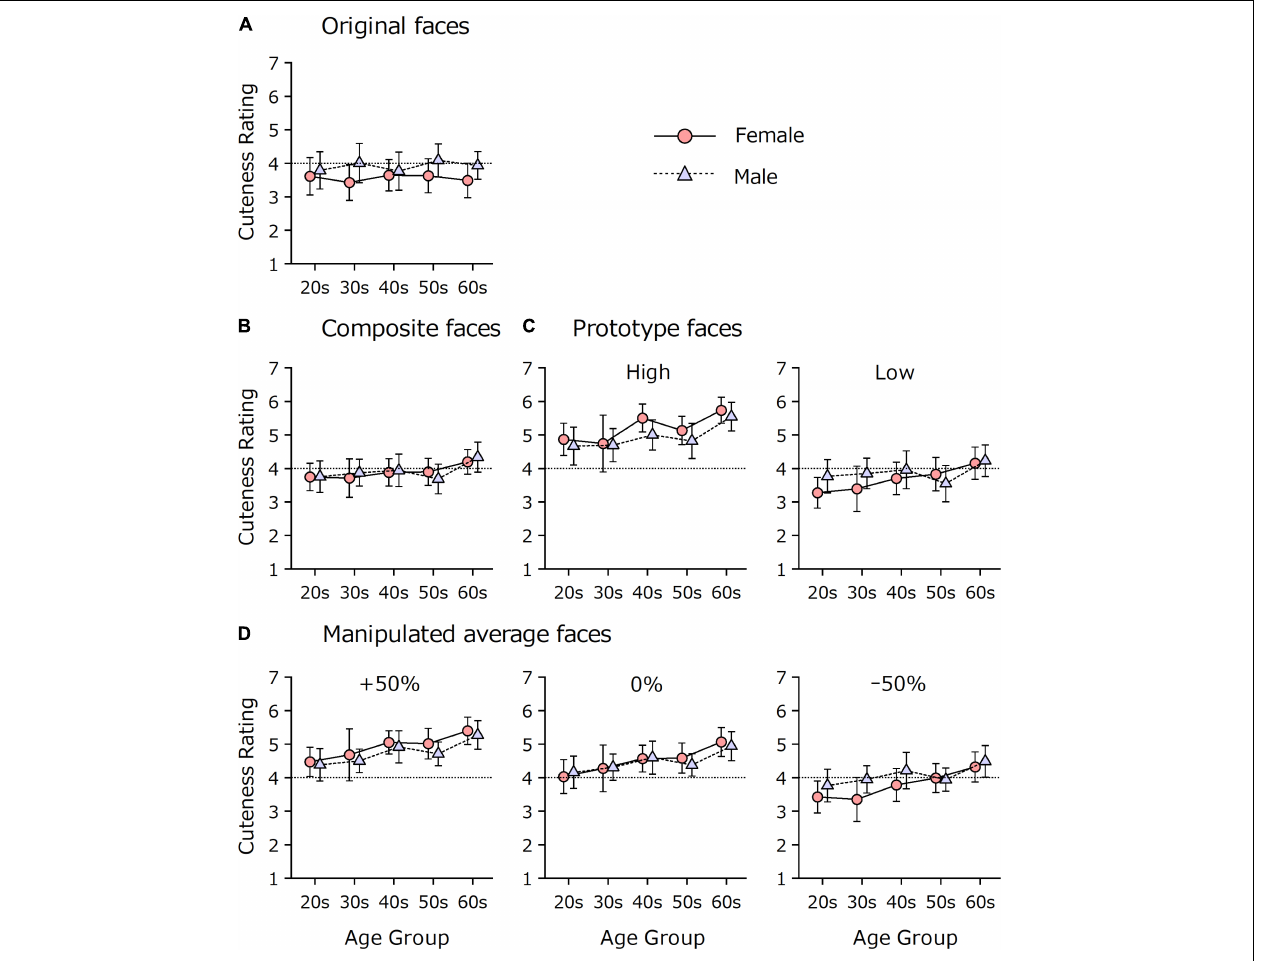
FIGURE 4 | Sex and age differences in cuteness ratings. 1 = not cute (kawaii) at all , 7 = extremely cute (kawaii). Error bars indicate 95% confidence intervals. (A) The data on 80 original faces. (B) The data on 50 composite faces. (C) The data on prototype faces. (D) The data on manipulated average